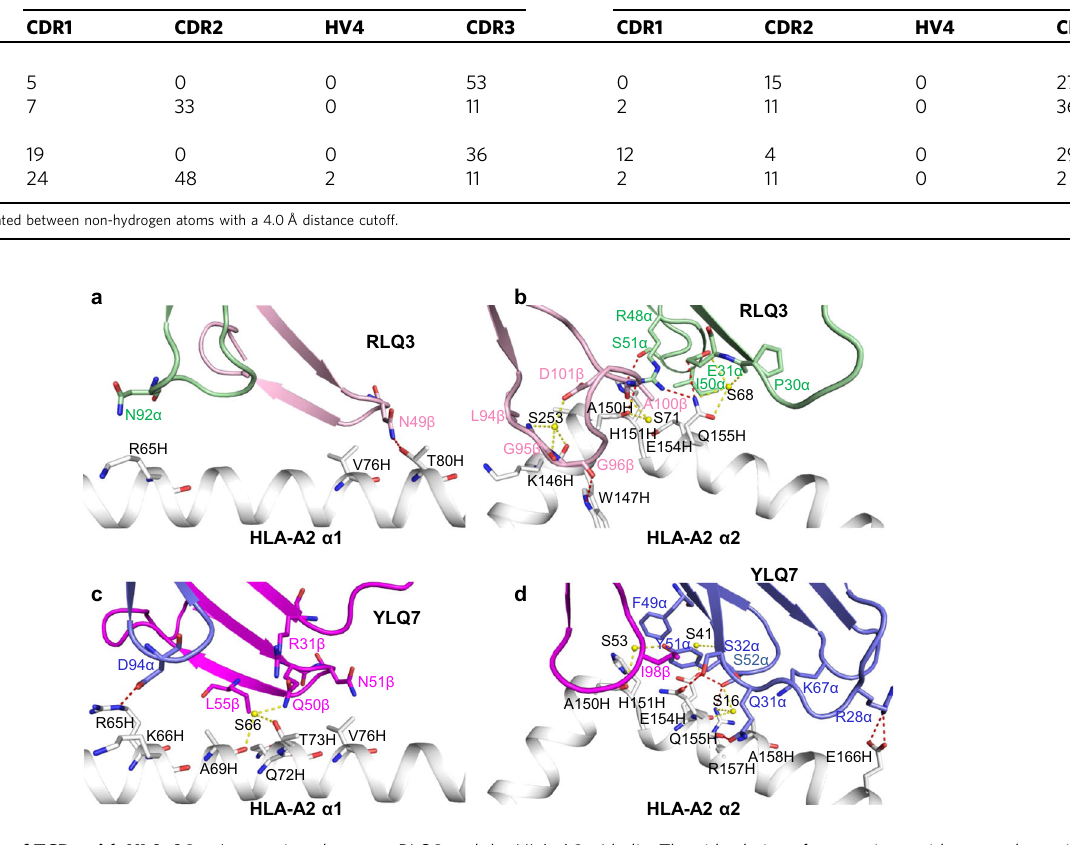
Table 2 TCR CDR atomic contacts with peptide and MHC (percentage of contacts). α chain